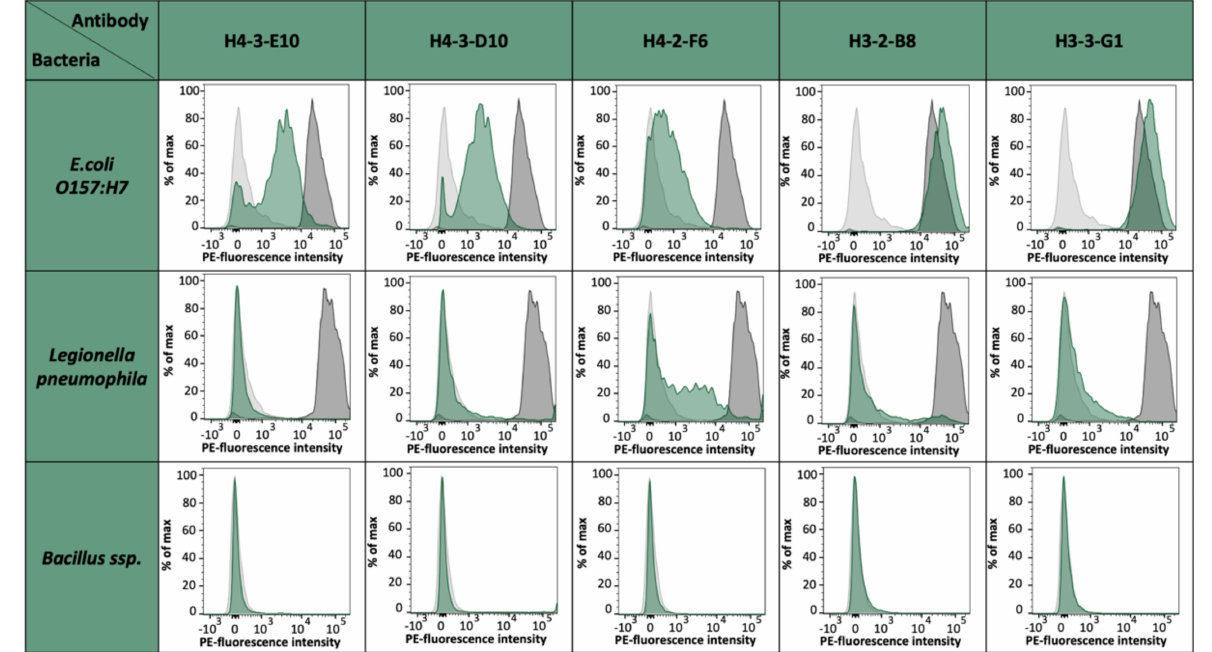
Figure 6. Characterization of the mAbs against E. coli O157:H7, Legionella pneumophila and Bacillus spp. for antibody binding and cross-reactivity. Antibody binding was measured in flow cytometry (green). Two million cells were stained with 10 µ g/mL of H4-3-E10, H4-3-D10, or H4-2-6 in MACS buffer. For H3-2-B8 and H3-3-G1, undiluted culture supernatants were used for the staining. As positive control (dark gray), a polyclonal rabbit anti- E. coli Ab was used for E. coli O157:H7 and a mouse anti- Legionella pneumophila Ab was used for Legionella pneumophila . For Bacillus spp., there is no specific antibody available for flow cytometry measurements. The negative controls (light gray) are stainings only with the PE coupled detection